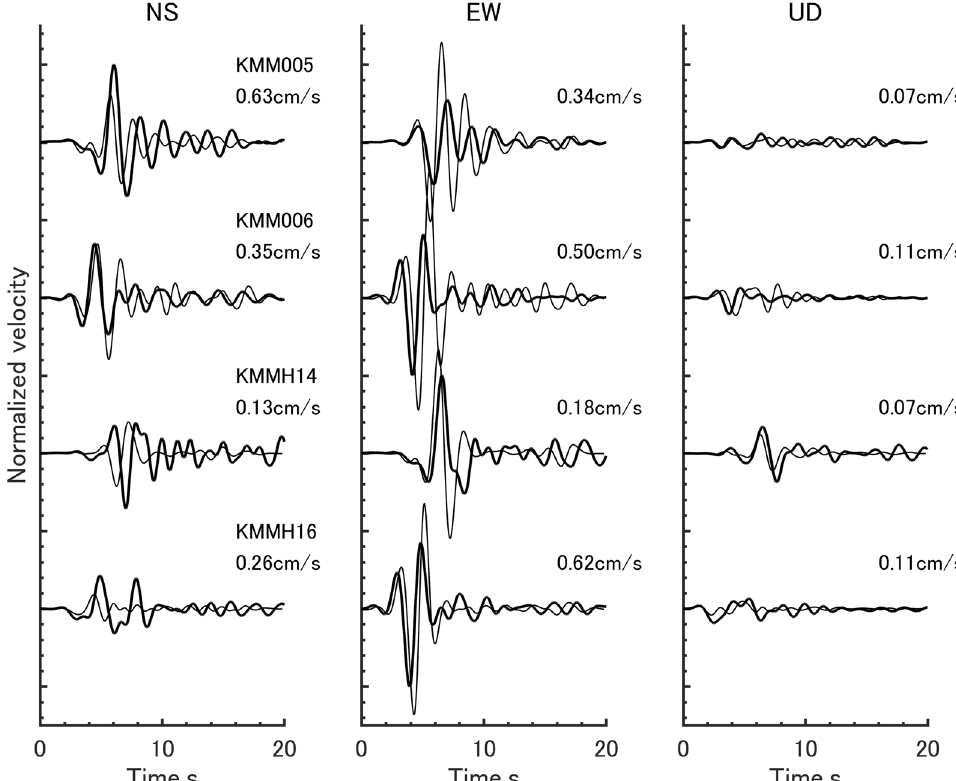
Fig. 3 Velocity structure validation. Comparison of observed (thick) and simulated (thin) velocity waveforms for Mw4.9 earthquake on 14 Apr 2016, 23:43 (EGF1 event in Somei et al. 2019), filter 1.5–10 s